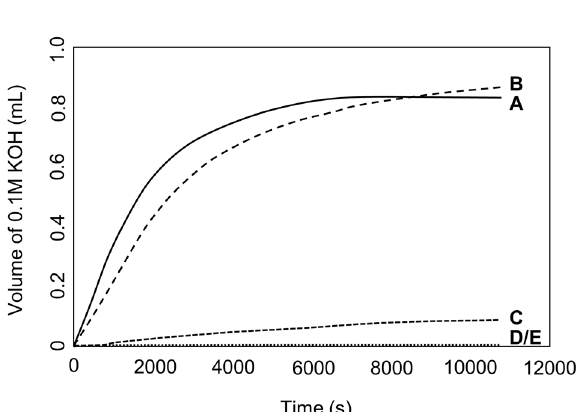
Fig. 5 Volume 0.1 M KOH solution vs time curves for experiments performed in the DCPD metastable zone. A growth of DCPD on DCPD seed material; B growth of DCPD on DCPD seed material in the presence of alanine; C growth of DCPD on DCPD seed material in the presence of glutamic acid; D growth of DCPD on DCPD seed material in the presence of phosphoserine; E growth of DCPD on CPP seed material